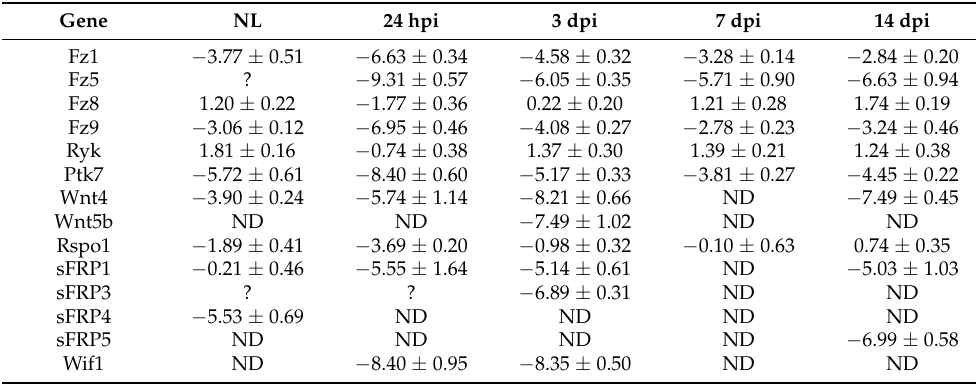
Table 1. ∆ Cts values ± SEM of all the detected genes at the different times post-injury that were evaluated. NL: non-lesioned; hpi: hours post-injury; dpi: days post-injury; ND: non detected; ?: inconclusive